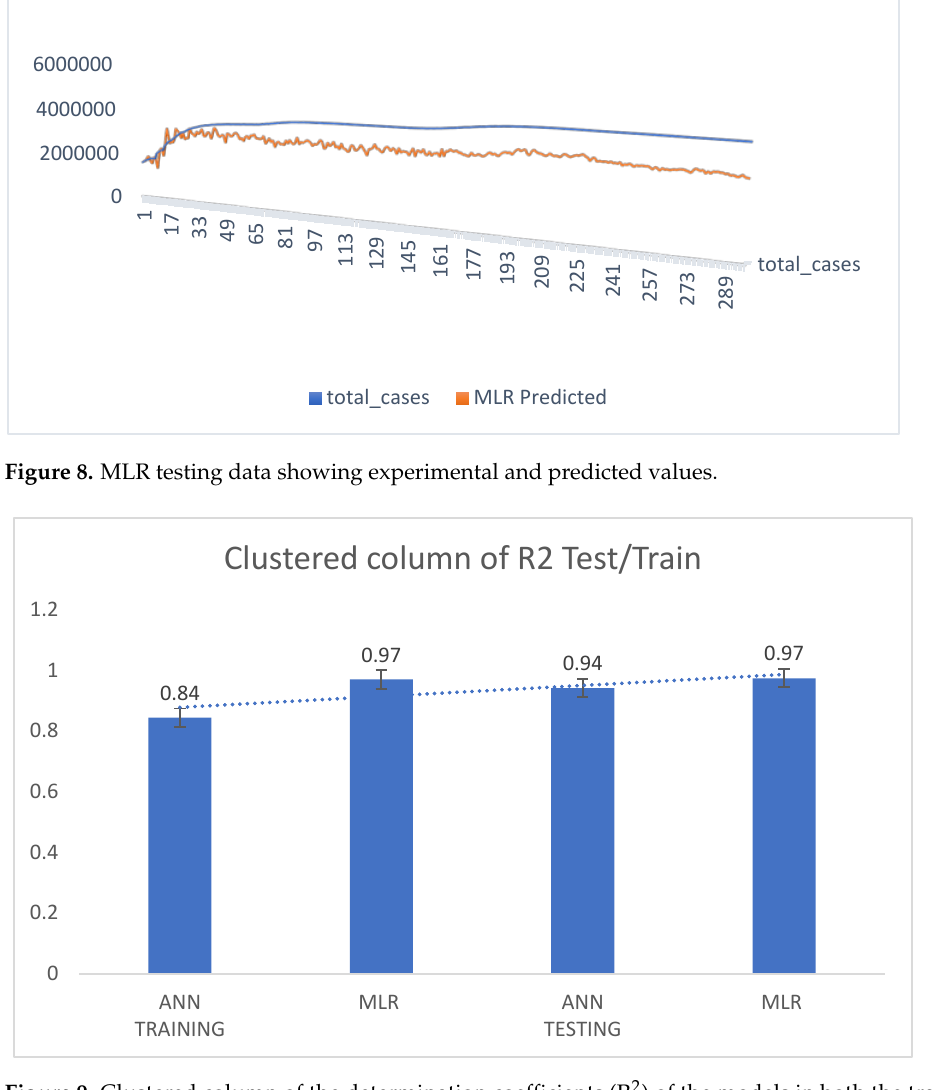
Figure 9. Clustered column of the determination coefficients (R 2 ) of the models in both the training and testing